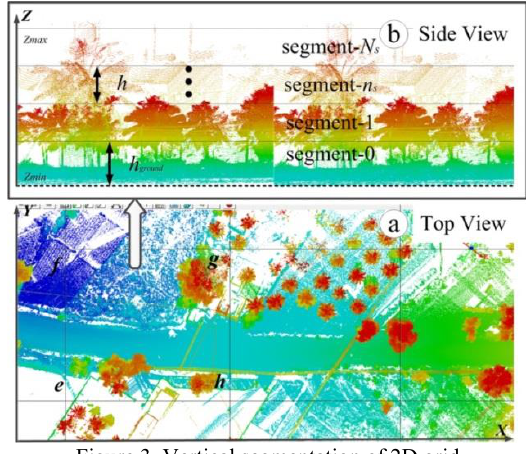
Figure 3. Vertical segmentation of 2D